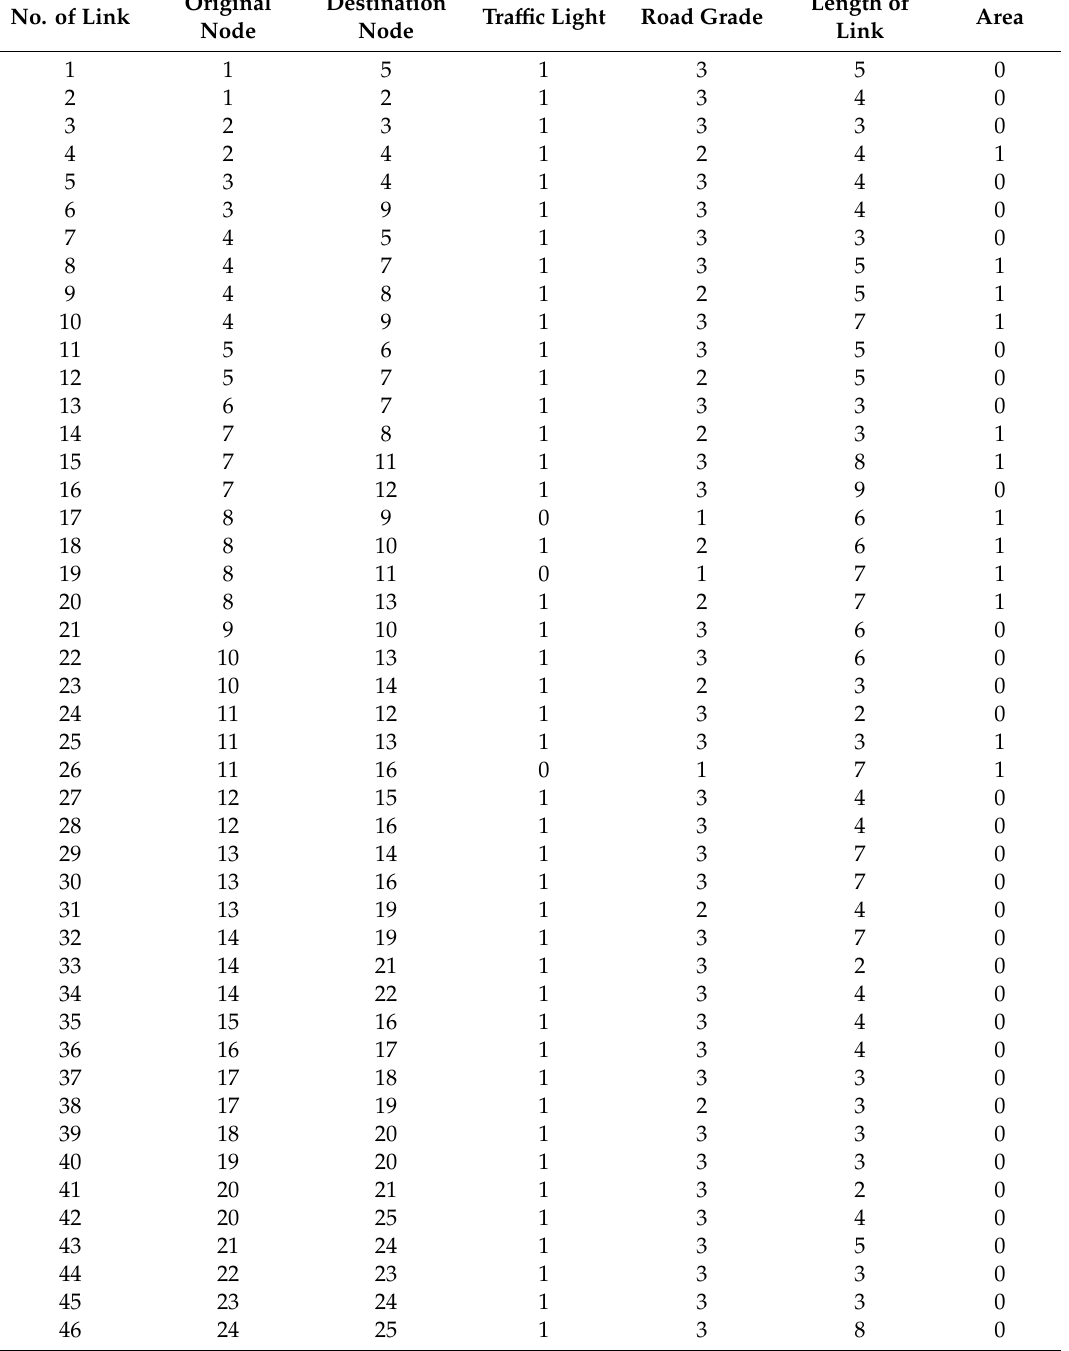
Table 4. Detailed information for the road network.